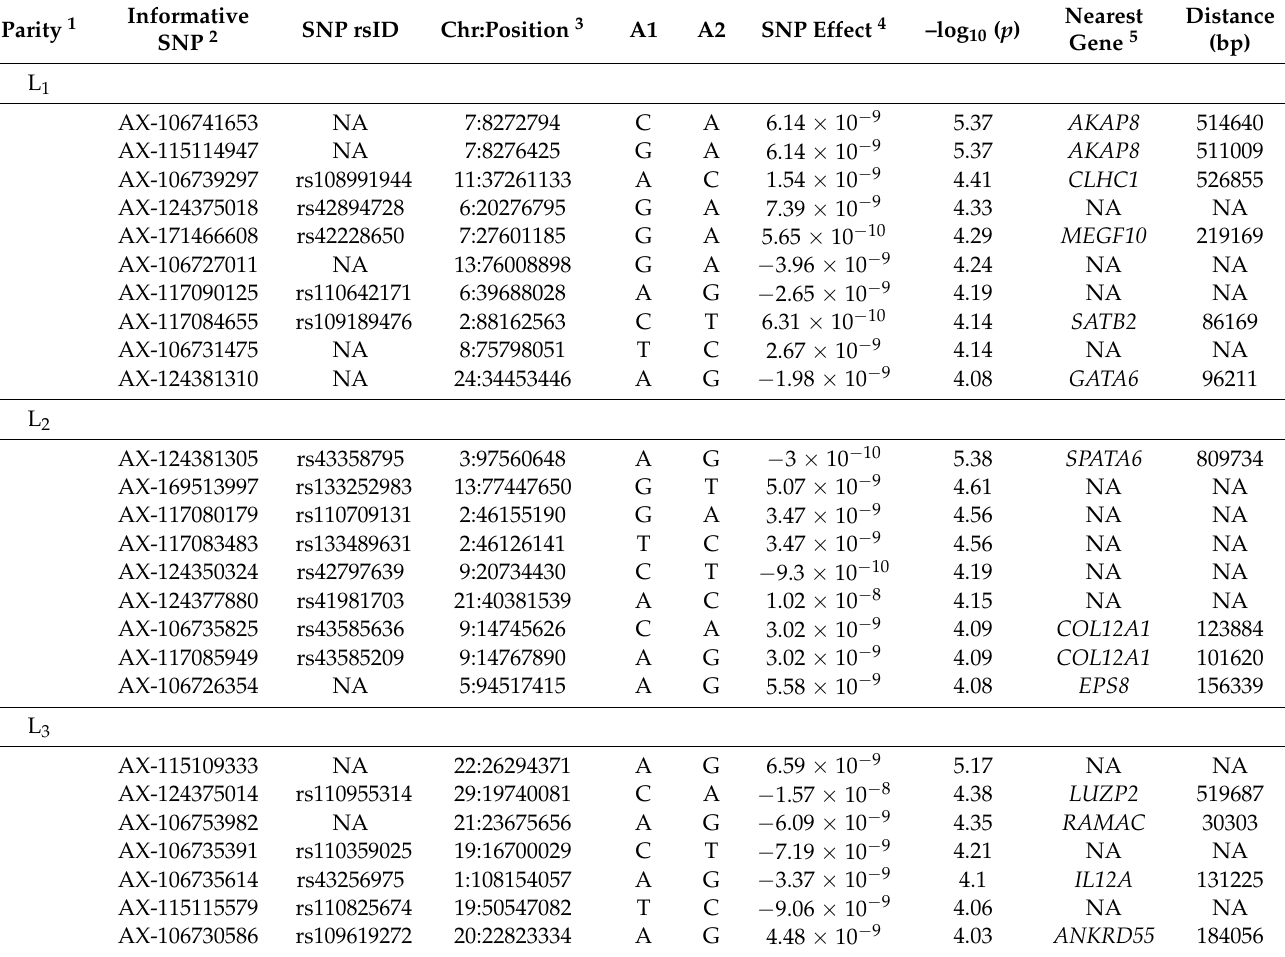
Table 3. List of SNPs in the Bos taurus autosomes showing significant ( − log 10 ( p ) ≥ 4.00) associations with SCS in the Romanian Brown